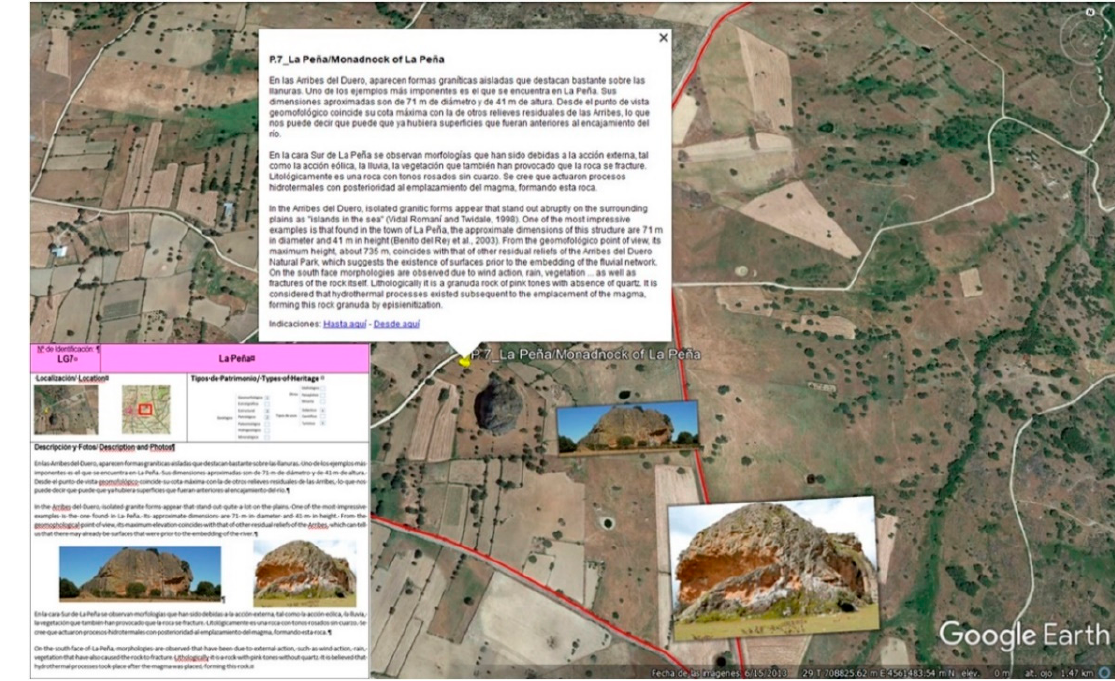
Figure 5. Screenshot of geosite P-7 (La Peña) with photos and sheet of geosite.